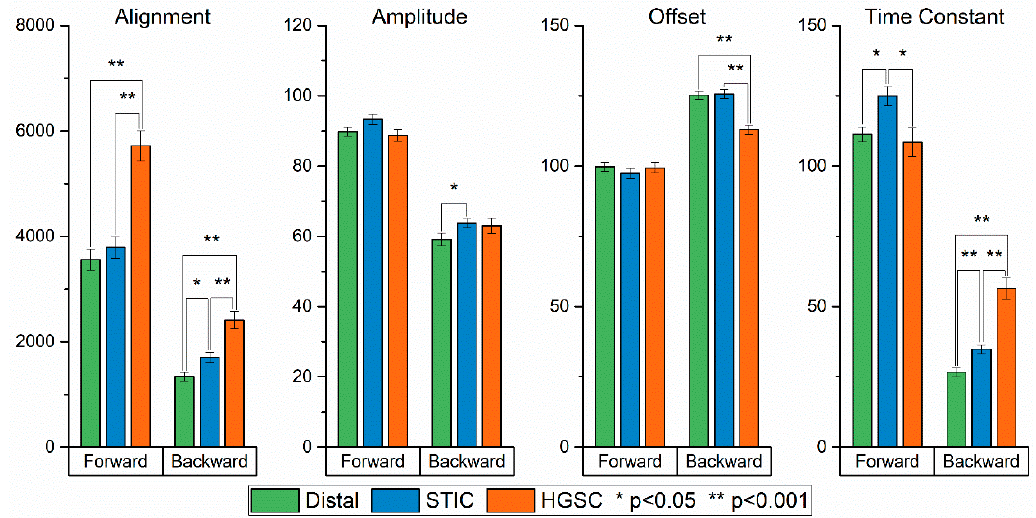
Figure 5. Bar plots of the mean value for each group in all four of the outputs calculated in the 2D-FFT analysis. (*) and (**) correspond to p < 0.05 and p < 0.001, respectively.